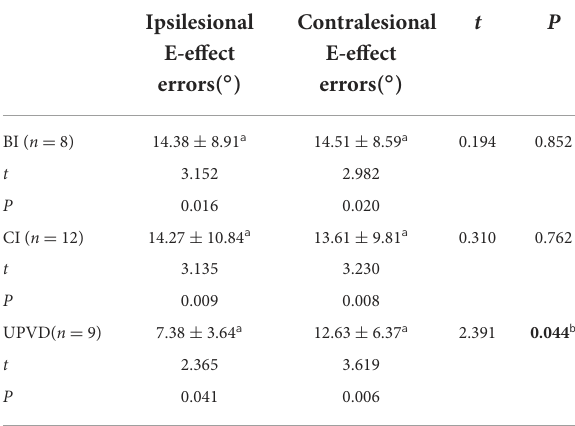
TABLE 3 Absolute values and symmetry analysis of the bilateral E-effect according to